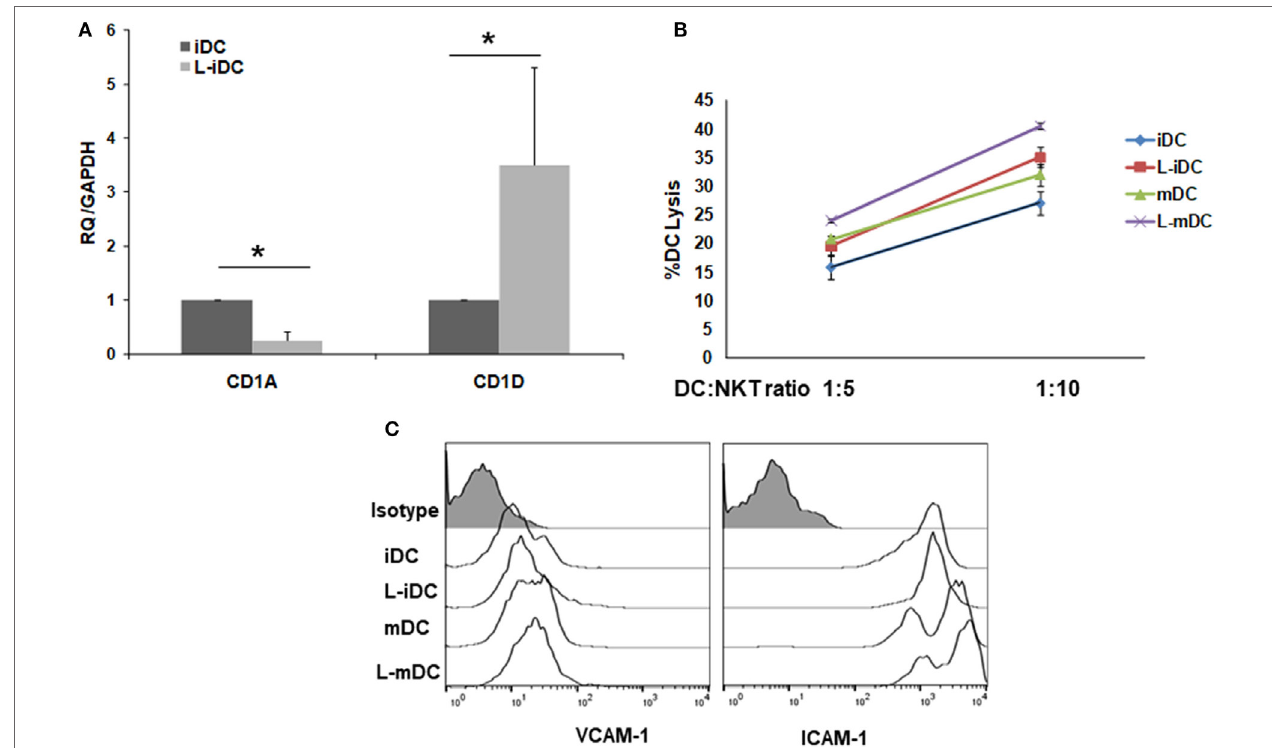
FigUre 2 | CD1A and CD1D genes are counter-regulated in L-iDCs. The increase in CD1D expression results in enhanced recognition of L-iDCs by NKT cells. (a) Relative quantification of CD1A and CD1D gene transcript levels in control dendritic cells (DCs) and L-DCs. Data (mean ± SDs) from four independent experiments are shown. (B) α -GalCer-loaded L-iDCs or iDCs were co-cultured with previously purified NKT cells at two different ratios for 4 h. A lactate dehydrogenase detection kit was used to measure the lysis of DCs. The average of four independent experiments is shown (* p < 0.05). (c) Expression of VICAM-I and ICAM-I on DCs. A representative from four experiments is